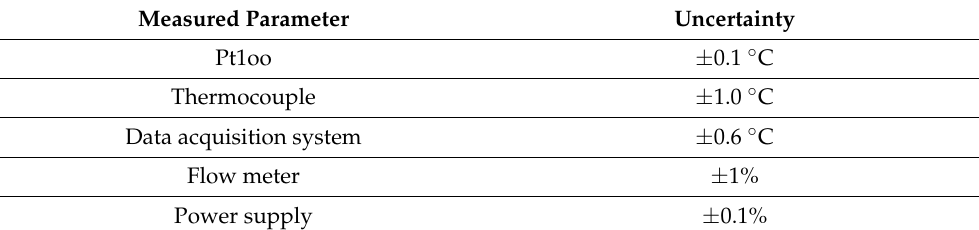
Figure 2. The schematic representation ( a ) and photo ( b ) of the established experimental setup. Table 2. Uncertainties for measured